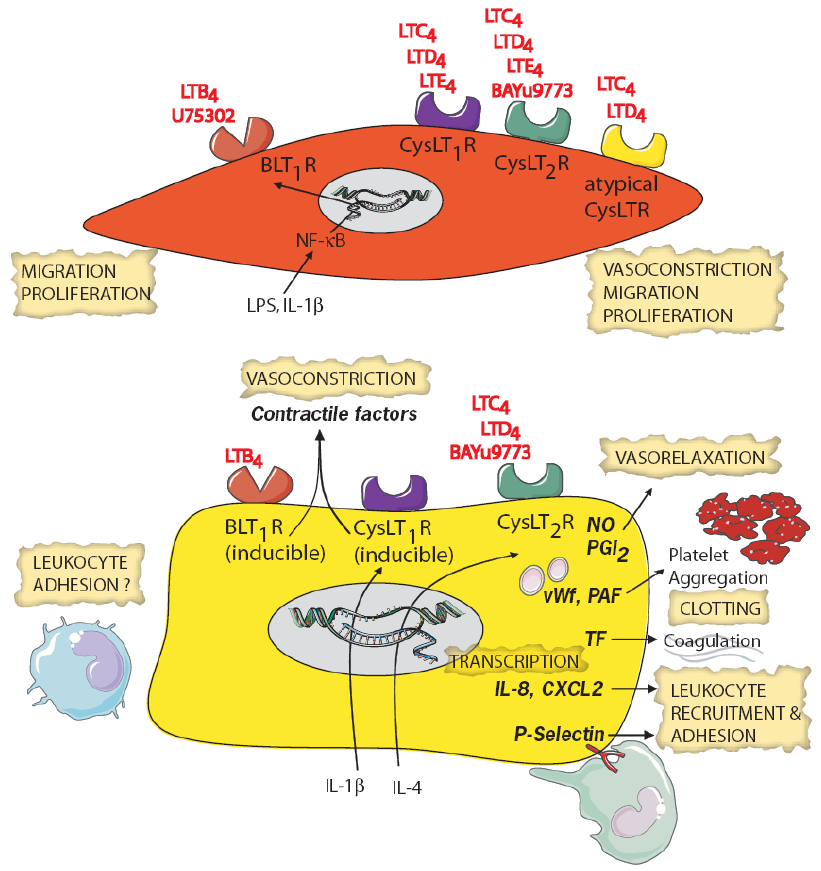
FIGURE 3. Schematic drawing of LT receptor expression and signaling on vascular SMCs (top) and ECs